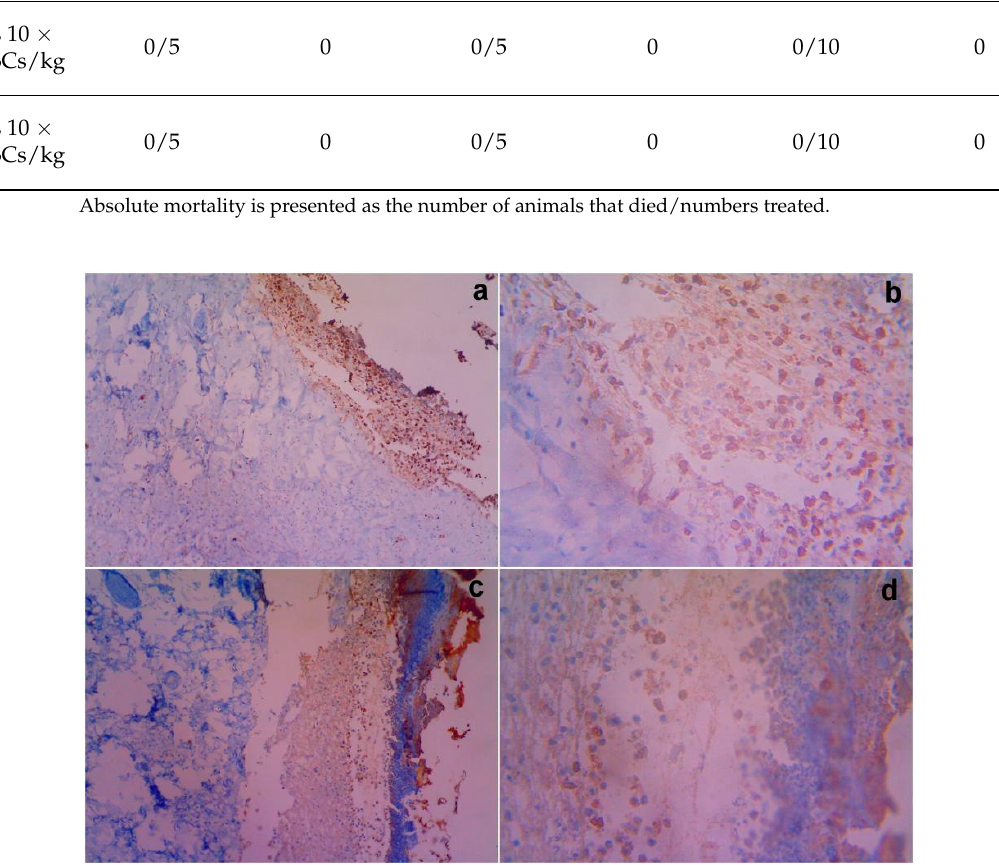
Figure 6. Gross histopathological examination of the different post excision for COX-2 nuclear and cytoplasmic immunoreactive positivity with treated rats on day 14. Representative images of the COX-2 nuclear and cytoplasmic section stand for ( a ) 10× showing magnification of the control showing 3(+) immunoreactivity compared with Group II ( c ) showing 2(+) immunoreactivity for MSCs, ( b ) 40× showing magnification of 3(+) immunoreactivity by the vehicle control, and ( d ) 40× showing magnification of 2(+) immunoreactivity by the test article, respectively.